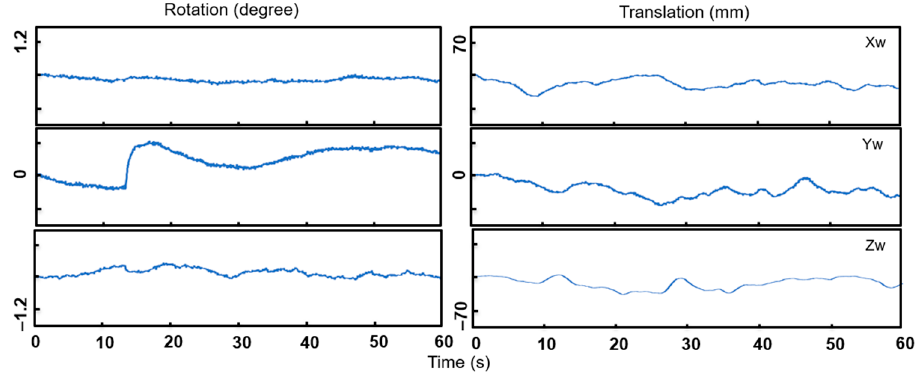
Figure 10. Six degrees of freedom motion of the UAV ( Z w = 0).